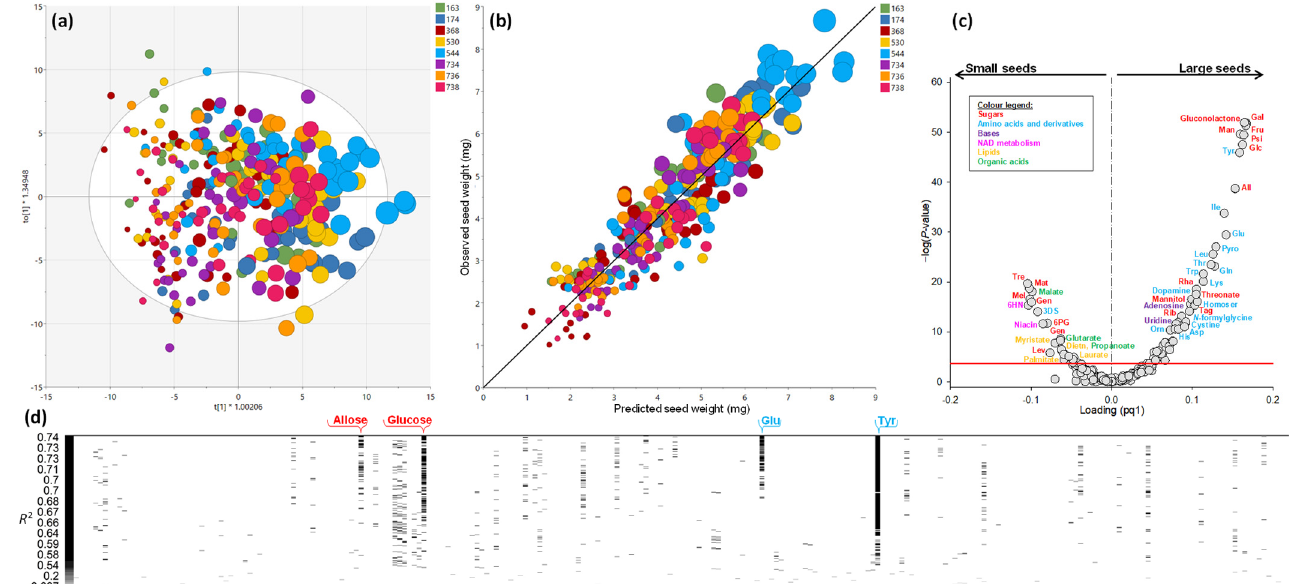
Figure 3. Seed metabolome. ( a ) Score plot of the multivariate analysis (OPLS) showing the discrim- ination of seed size along axis 1. Seed size is reflected by symbol size, while accessions are shown with colours. The white region stands for Hotelling’s ellipse. ( b ) Relationship between observed seed size and seed size predicted by the statistical OPLS model. The black line stands for the 1:1 relationship. ( c ) Volcano plot showing best discriminant metabolites, with the OPLS loading ( x axis) and –log( p -value) in linear regression ( y axis). Most important metabolites are annotated, with met- abolic families shown in colours. ( d ) R 2 score plot showing best metabolites in multiple linear re- gression with variable elimination, implemented in R with the regsubsets function. The four best metabolites are annotated on top (allose, glucose, glutamate and tyrosine). Additional information on multivariate analysis is provided in Supplementary Figure S2. In panel ( c ), amino acids and sug- ars are abbreviated according to the international three-letter code. Other abbreviations are as fol- lows: 3DS, 3-dehydroshikimate; 6PG, 6-phosphogluconate; Homoser, homoserine; Lev, levogluco- san; Orn, ornithine; Pyro, pyroglutamate. Numerical values of loadings and –log( p ) used in panel ( c ) are tabulated in Supplementary Table S1. In ( a ), note that x and y axes have been renormalised to allow the visualisation of axes on the scale. A magnified version of this figure is available as Supplementary Figure S2.